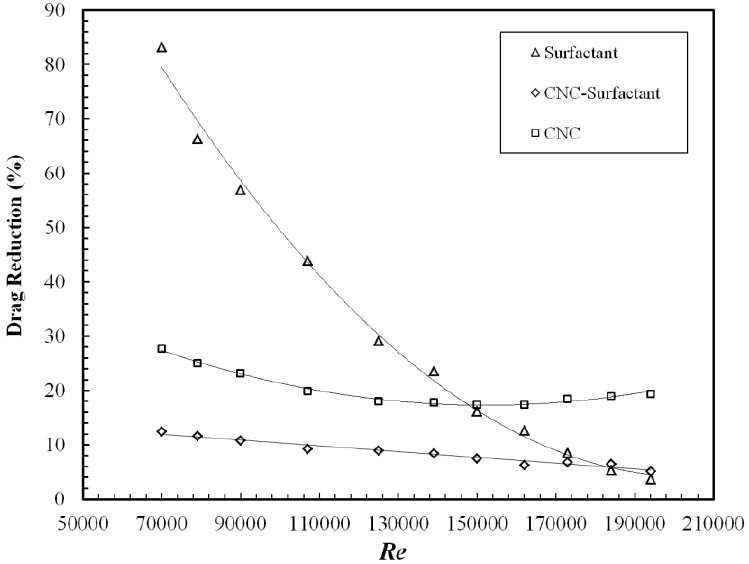
Figure 9. Drag reduction with increasing Reynolds number for CNC, Surfactant and CNC-Surfactant.